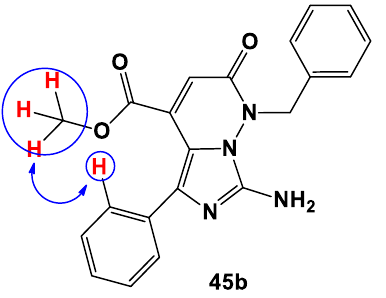
Figure 1. Key interactions for compound 45b in the NOESY spectra.